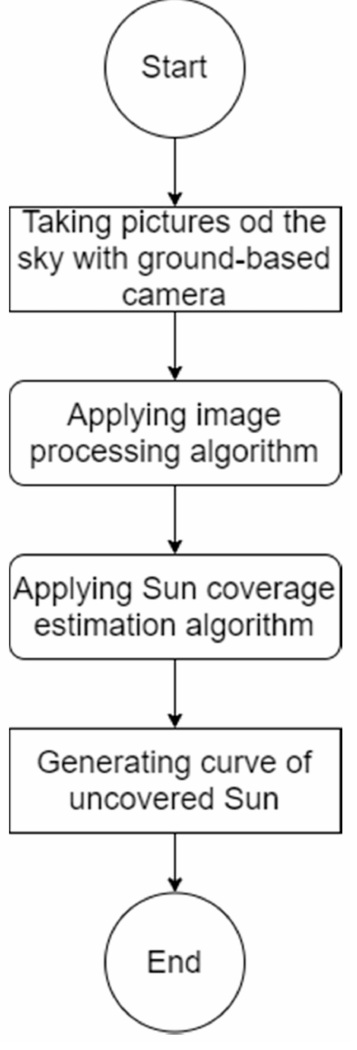
Figure 2. Master algorithm flow